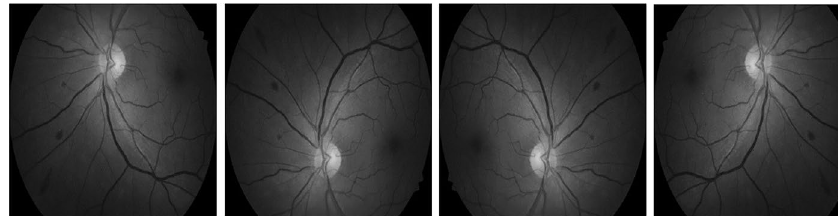
Fig. 10 Example of data